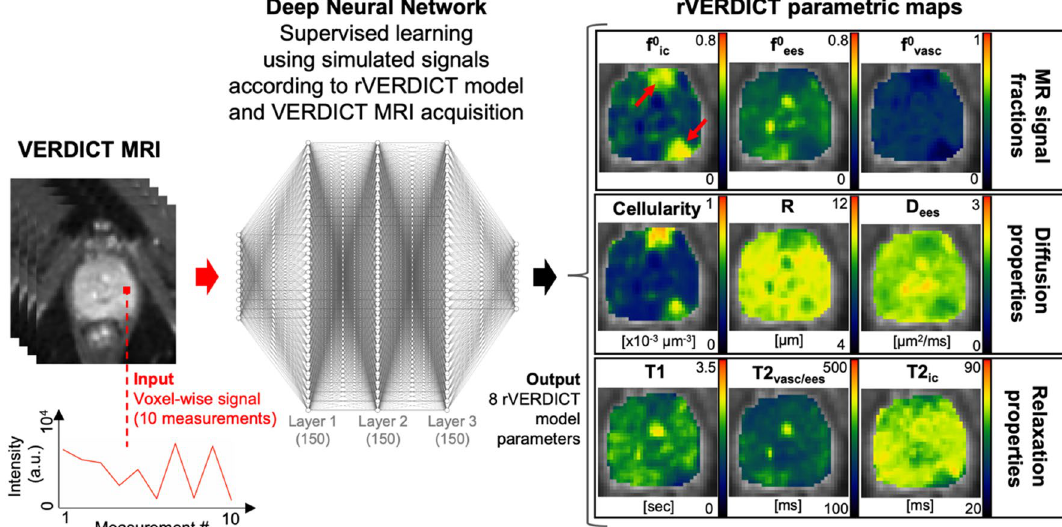
Figure 2. Examples of rVERDICT model parametric maps for a representative participant in our cohort: age late 60’s, PSA 5.21 left posterior lesion Gleason 3 + 4 maximum cancer core length (MCCL) 14 mm, left anterior lesion Gleason 3 + 3. A flowchart of the rVERDICT fitting using a fully connected deep neural network (DNN) is also shown. The DNN takes voxel-wise signals as input and outputs voxel-wise values of the eight rVERDICT model parameters. It is trained in a supervised fashion, using simulated noisy signals according to the rVERDICT model and the VERDICT MRI acquisition. Exemplar training data are shown in Supplementary Fig.